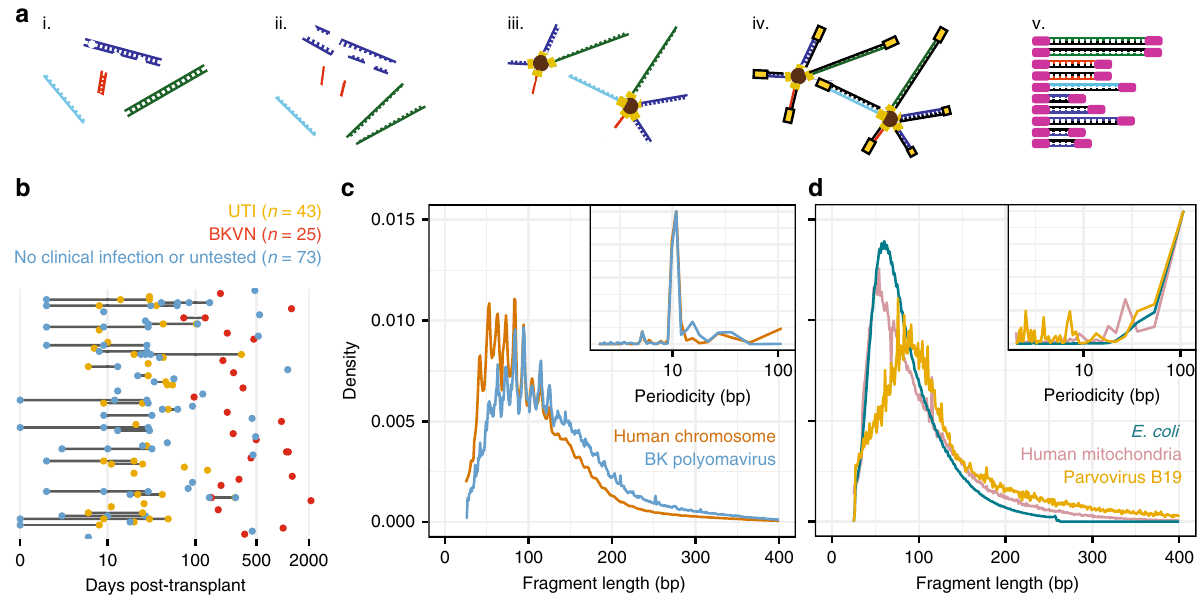
Fig. 1 Shotgun sequencing assay and biophysical properties of urinary cfDNA. a Schematic representation of the ssDNA library preparation protocol used for shotgun sequencing of urinary cfDNA 20 . Key steps include: (i) cfDNA isolation, (ii) DNA denaturation, (iii) ssDNA adapter ligation, (iv) extension and double-stranded DNA adapter ligation, and (v) PCR. b Overview of post-transplant sample collection dates (color indicates pathology, bars connect samples from same subjects). c , d Fragment length density plot measured by paired-end sequencing for different cfDNA types: c chromosomal and BKV cfDNA from representative samples, and d E. coli , parvovirus B19, and mitochondrial cfDNA from representative samples. Fourier analysis reveals a 10.4 bp periodicity in the fragment length pro fi les of chromosomal and BKV cfDNA but not for E. coli , parvovirus B19, or mitochondrial cfDNA (insets).